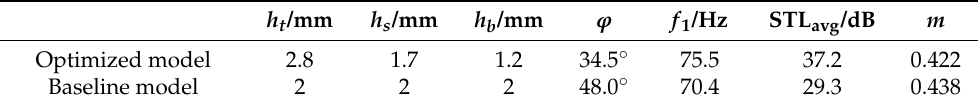
Table 4. Results after optimization in the middle-frequency range.